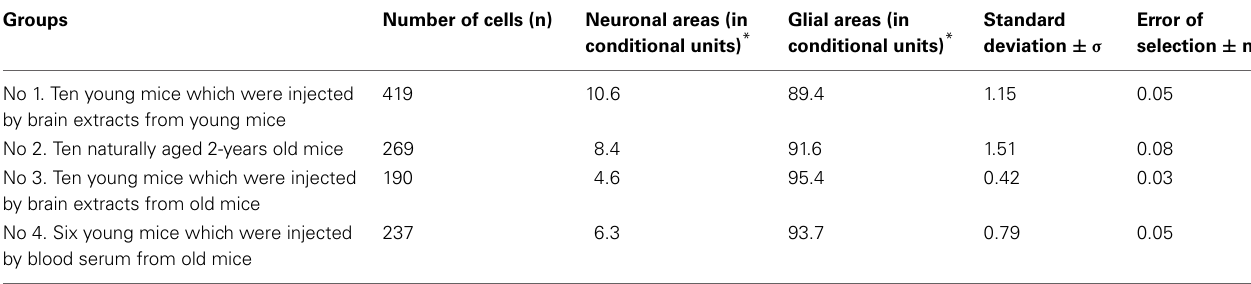
Table 1 | Dimension of neuronal and glial parts in the brain-cortex of young, natural, and artificial old mice.